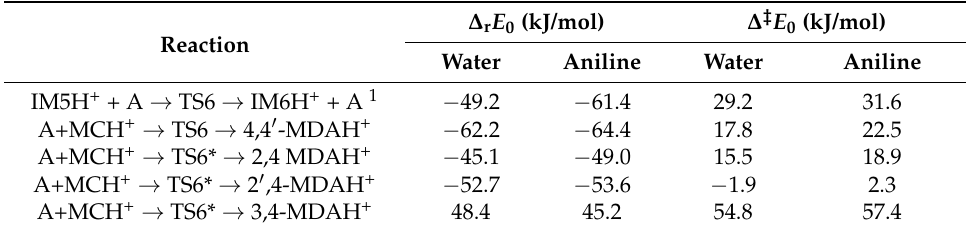
Table 5. Energetic description for aniline addition to 4-methylidene-cyclohexa-2,5-diene-1-iminium (MCH + ) reactions.